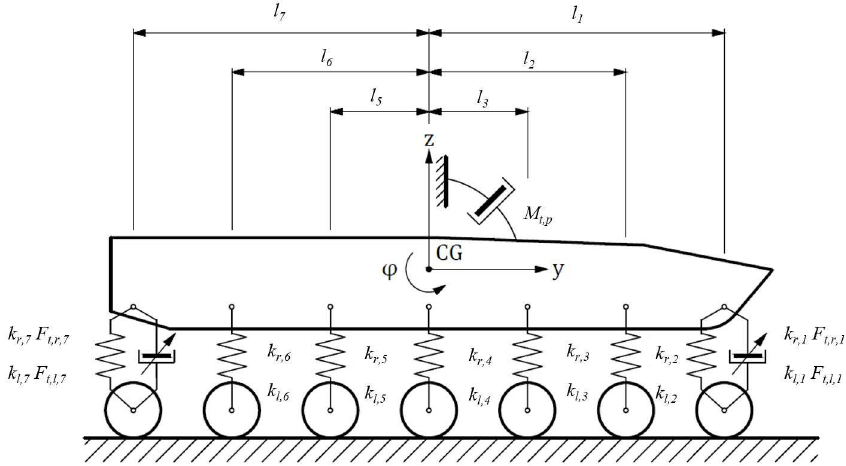
Figure 3. The rotational viscous damper, relevant for the pitch of the body.